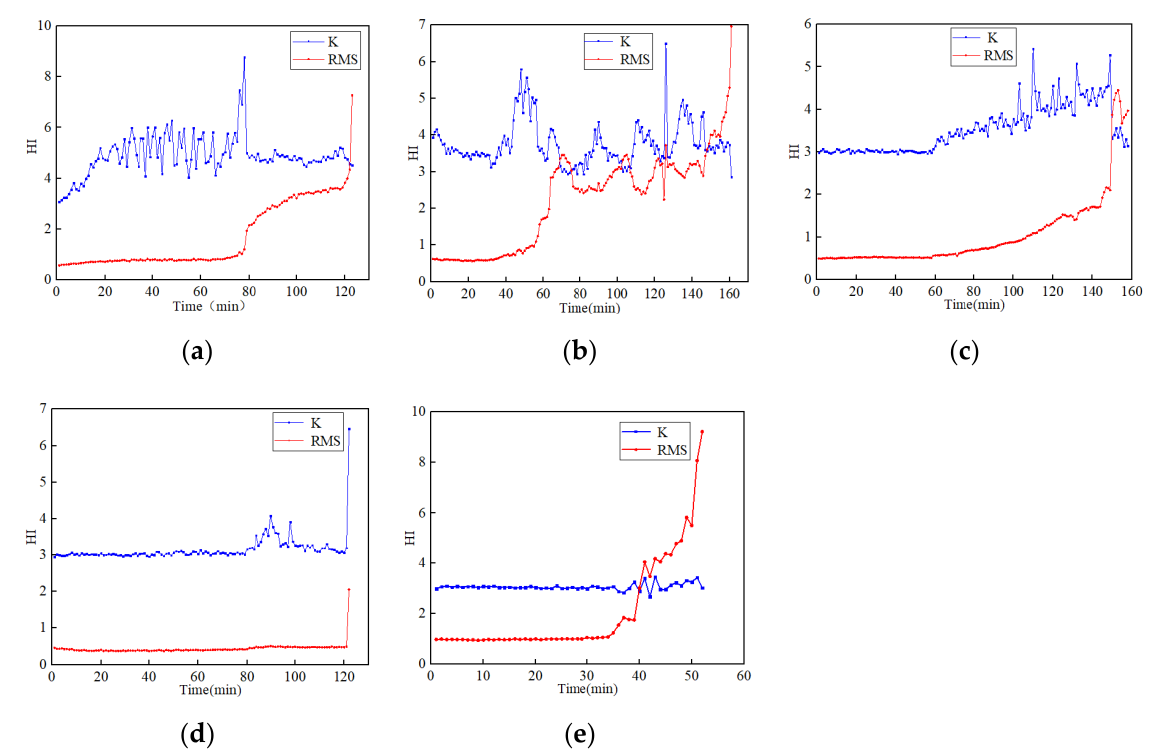
Figure 4. ( a ) HI of bearing1_1 ; ( b ) HI of bearing1_2; ( c ) HI of bearing1_3; ( d ) HI of bearing1_4; ( e ) HI of bearing1_5.